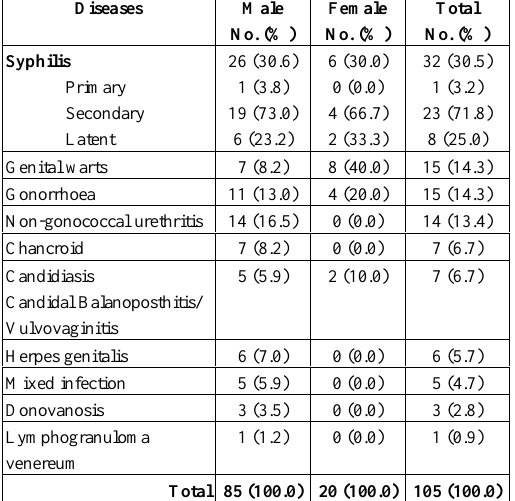
Distribution and Frequency of STDs (Sexually Transmitted Diseases) in the Study